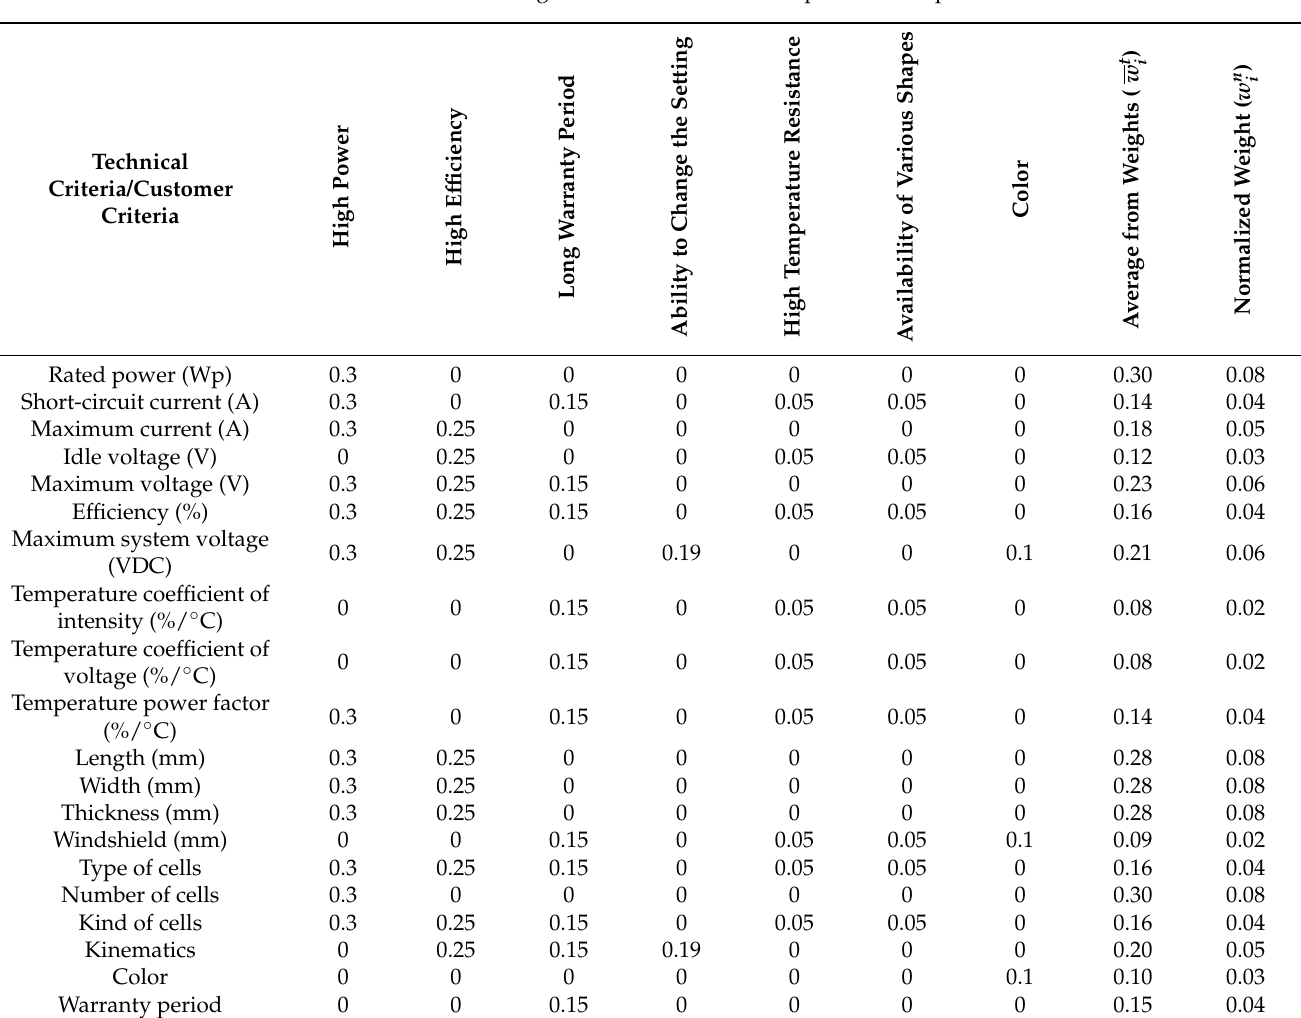
Table 4. Normalized weights of technical criteria of photovoltaic